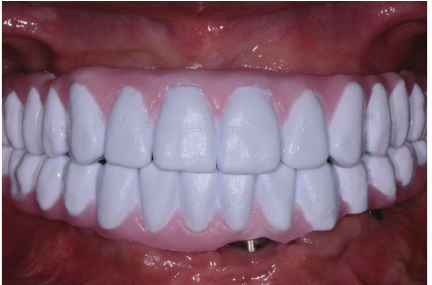
Figure 3: Smile view with artificial teeth arrangement.